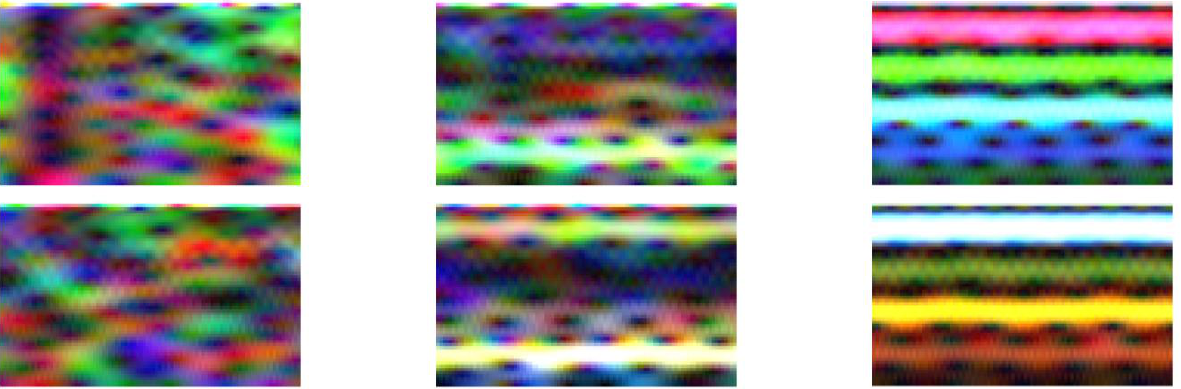
Figure 20. Time–frequency RGB images for class: idle ( left ), normal ( middle ), fault ( right ).